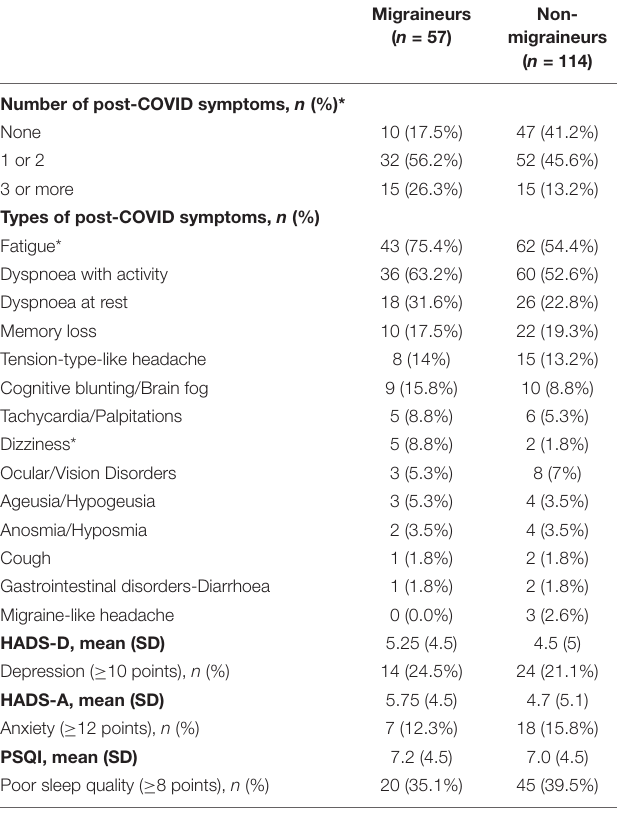
TABLE 2 | Prevalence of post-COVID symptoms in COVID-19 patients with and without pre-existing migraine history.